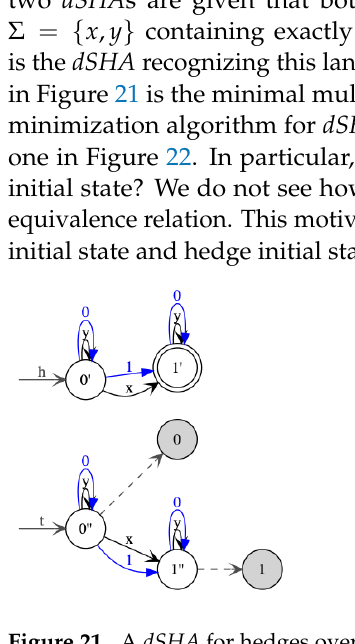
Figure 21. A dSHA for hedges over Σ = of multi-module dSHA